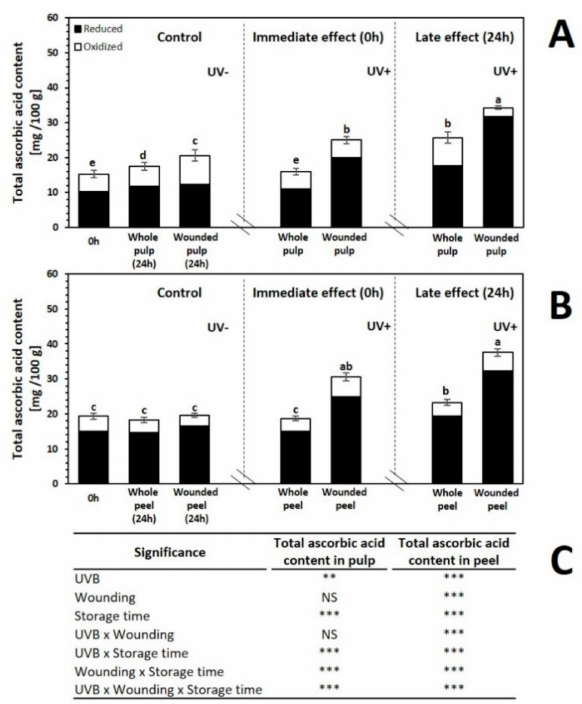
Figure 3. Concentration of ascorbic acid before and after storage (24 h at 16 ◦ C) of whole and wounded red prickly pear ( A ) pulp and ( B ) peel treated with UVB light (6.4 W · m − 2 ) for 0 and 15 min. ( C ) Full factorial analyses of variance showing the main e ff ects and interactions of the variables evaluated. Bars are means of five replicates ± standard error. Di ff erent letters among bars indicate statistical di ff erence between treatments using the least significant di ff erence (LSD) test ( p < 0.05). Asterisks indicate that main e ff ects and interactions are significantly di ff erent by analyses of variance (ANOVA). NS—non significant, * p < 0.05, ** p < 0.01, *** p < 0.001. Results are expressed as mg equivalents of ascorbic acid per 100 g of sample in dry weight